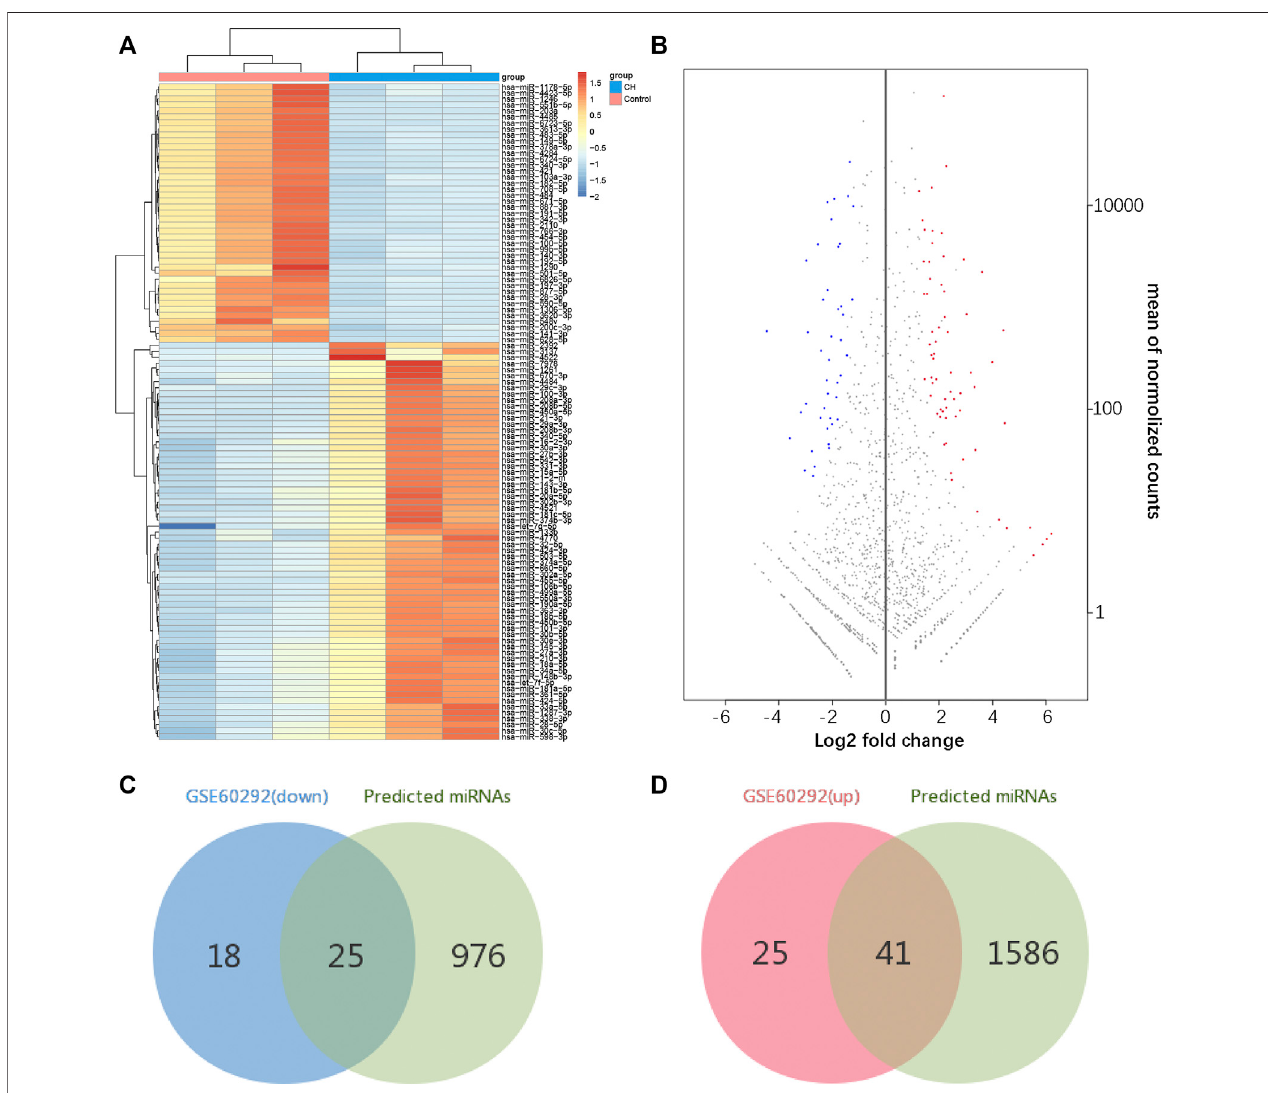
FIGURE 4 | Identi fi cation of differentially expressed miRNAs. (A) Hierarchical clustering heat map of differentially expressed miRNAs. (B) MA plot of differentially expressed miRNAs. (C,D) Identi fi cation of overlapping miRNAs in DEMs of GSE60292 and predicted miRNAs of DEGs.